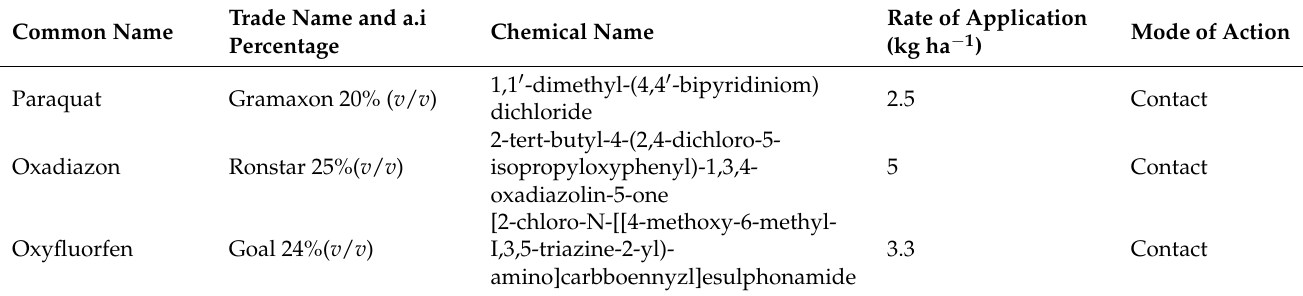
Table 2. Herbicides used for controlling Conyza bonariensis